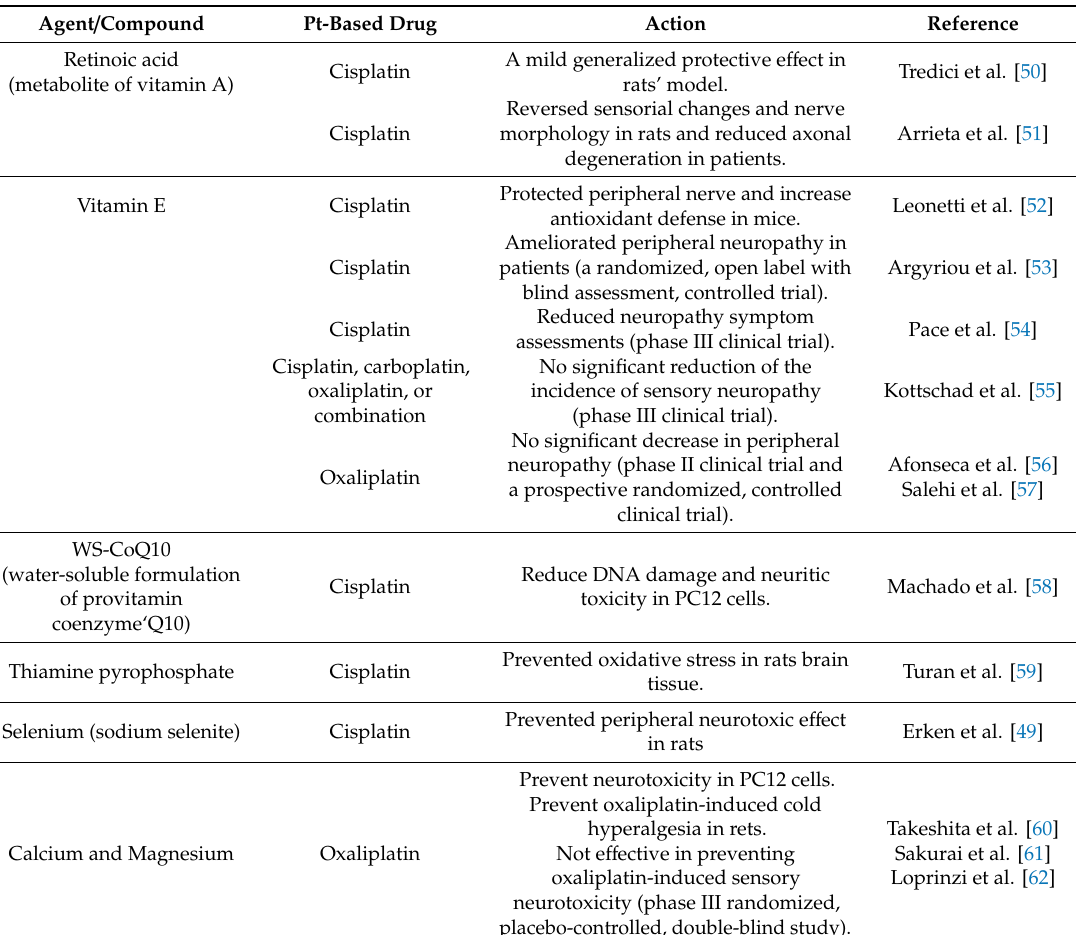
Table 2. Vitamins, dietetic supplements, and medication with neuroprotective activity against neurotoxicity induced by platinum-based